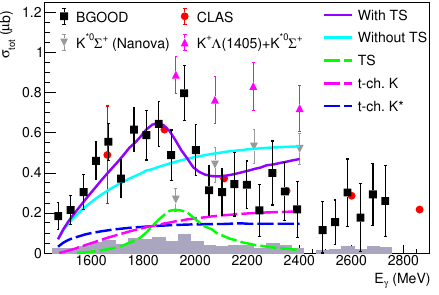
Figure 3. γ p → K + Λ di ff erential cross section > 0 . 90 (black fi lled circles). The for cos θ K CM systematic uncertainties on the abscissa are in three components, where the grey bars are the total. Previous data (only including statistical errors) is indicated in the legend. The CLAS data are at the more backward angle of 0.85 < cos θ K < 0.95. The RPR, BS1, and BS3 are CM the Regge plus resonant model and isobar models BS1 and BS3 of Skoupil and Bydžovský. The Bonn-Gatchina PWA solutions are shown with and without the inclusion of the new data. Figure and references in Ref.